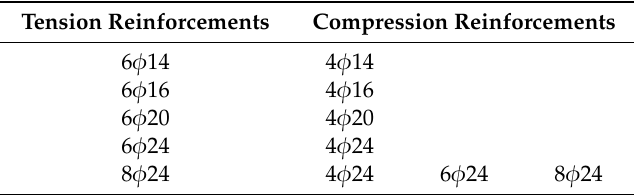
Table 2. Compression and tension reinforcement in the flat